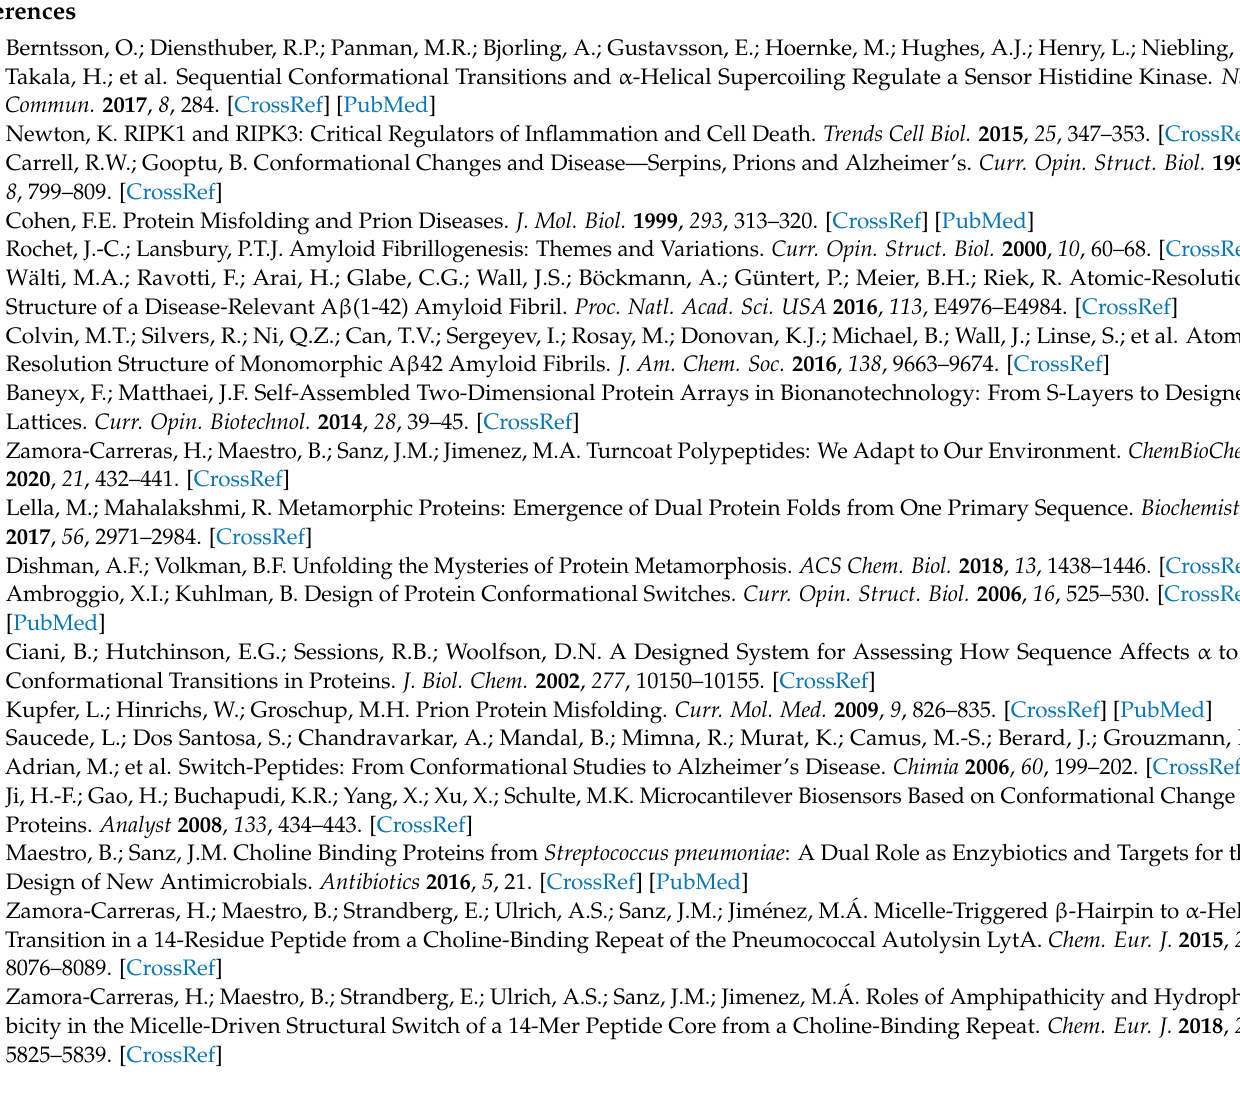
S7: Optimization of light pulse duration. Figure S8: Optimization of light intensity for optimized light pulse value. Figure S9: Expansion of 1 H-NMR spectra for 2 mM LyA 239–252 for dark (top) and light (bottom) conditions in the absence of micelle and in 2.5 mm NMR tubes. Figure S10: Expansion of the 1 H-NMR spectra for 2 mM LyA 239–252 for dark (top) and light (bottom) conditions in the presence of micelle (2